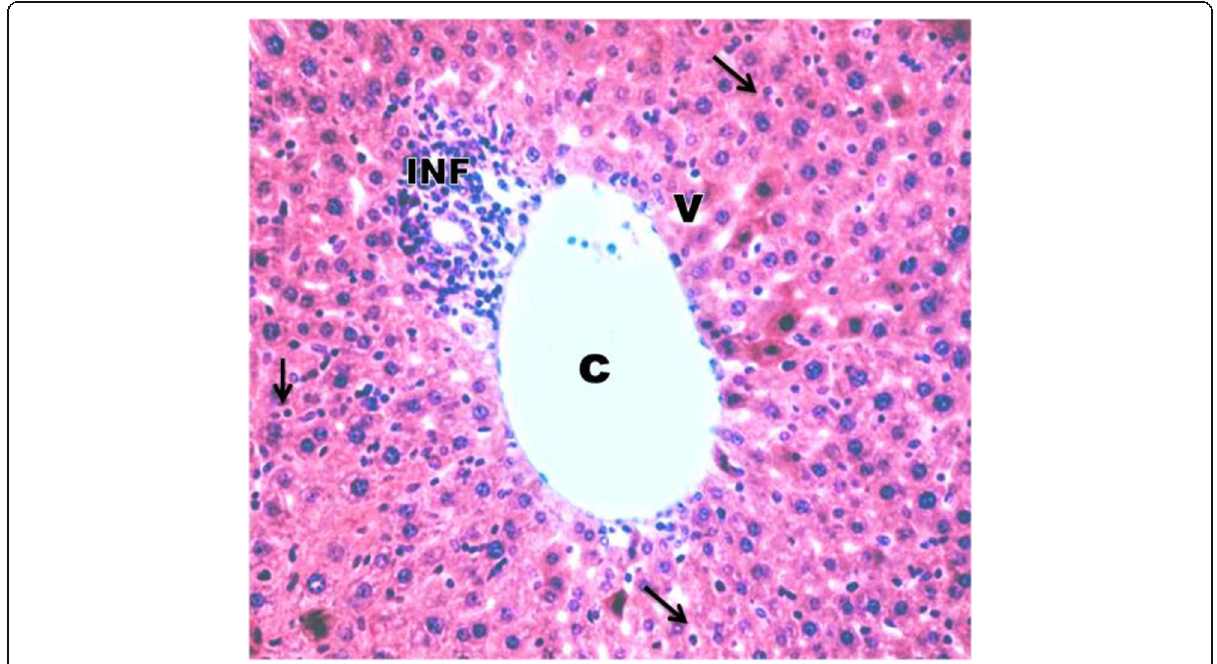
Fig. 6 Photomicrograph of a section of the liver of treated mouse with Adamine (20 mg/kg b.wt.) for 5 days revealing hepatocytes with clear vacuoles (V) and pyknotic nuclei (arrows), notice accumulation of inflammatory cells (INF) in the vicinity of central vein (C). (H&E, ×